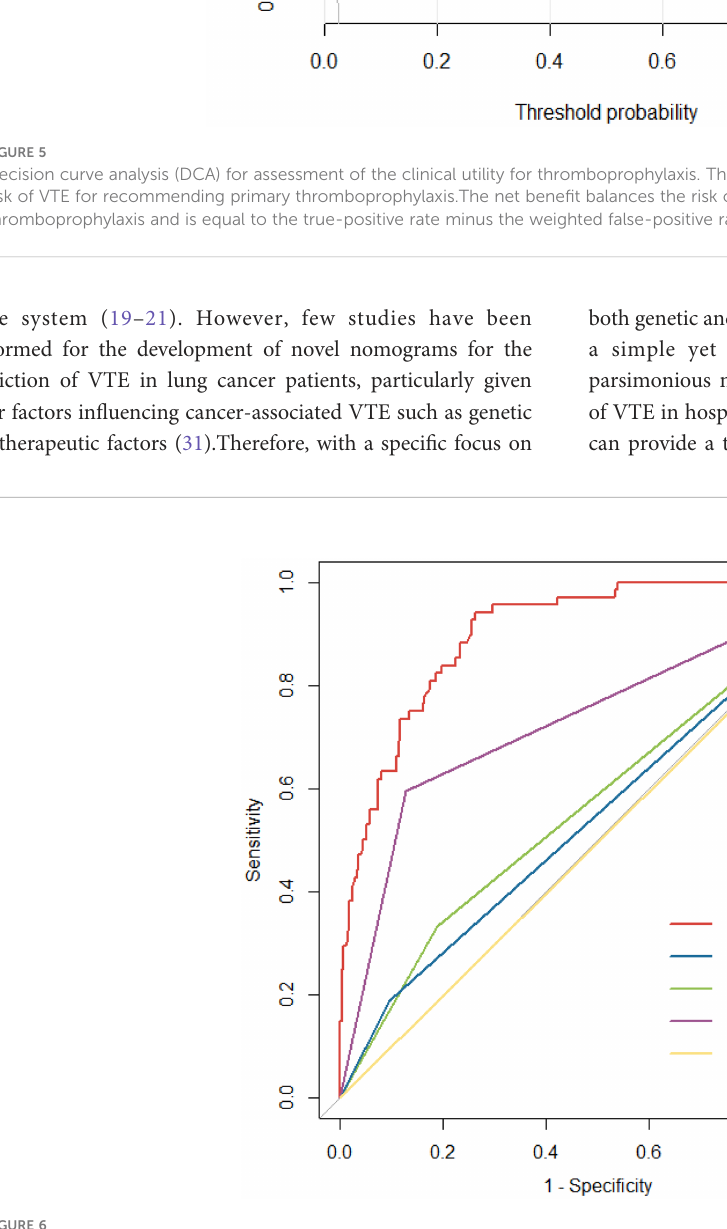
FIGURE 6 ROC curves for the existing risk assessment models [Khorana score(green line), Caprini risk assessment model(yellow line), Padua score(blue line) and COMPASS-CAT model(purple line)] and nomogram model (red line). ROC, receiver operating characteristic; AUC, area under the